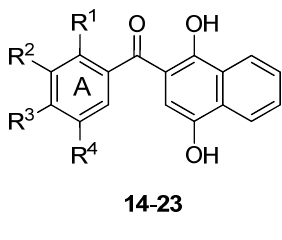
Table 2. In vitro inhibitory effect of compounds 3 – 23 on the proliferation of the human-derived tumor cell lines: T24 (bladder), DU-145 (prostate) and MCF7 (breast) and the non-tumor fibroblasts